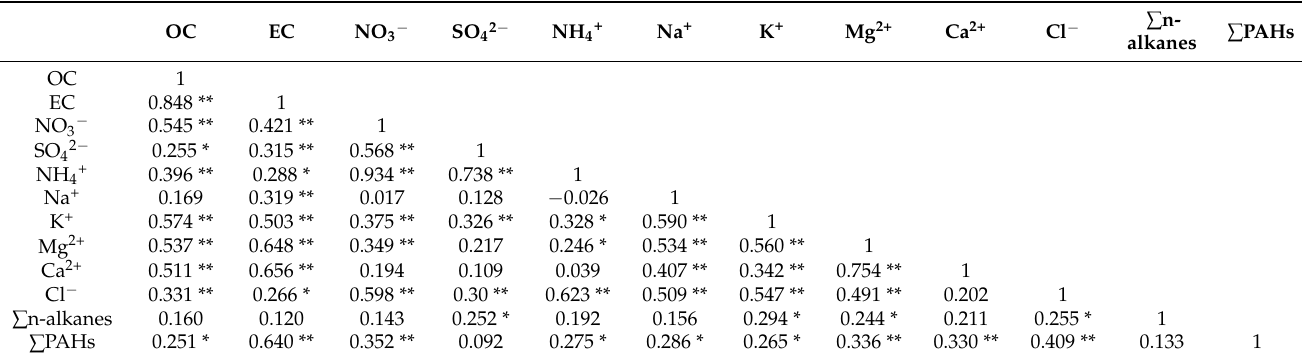
Table 4. Correlations between n-alkanes, PAHs and other chemical species in PM 2.5 .